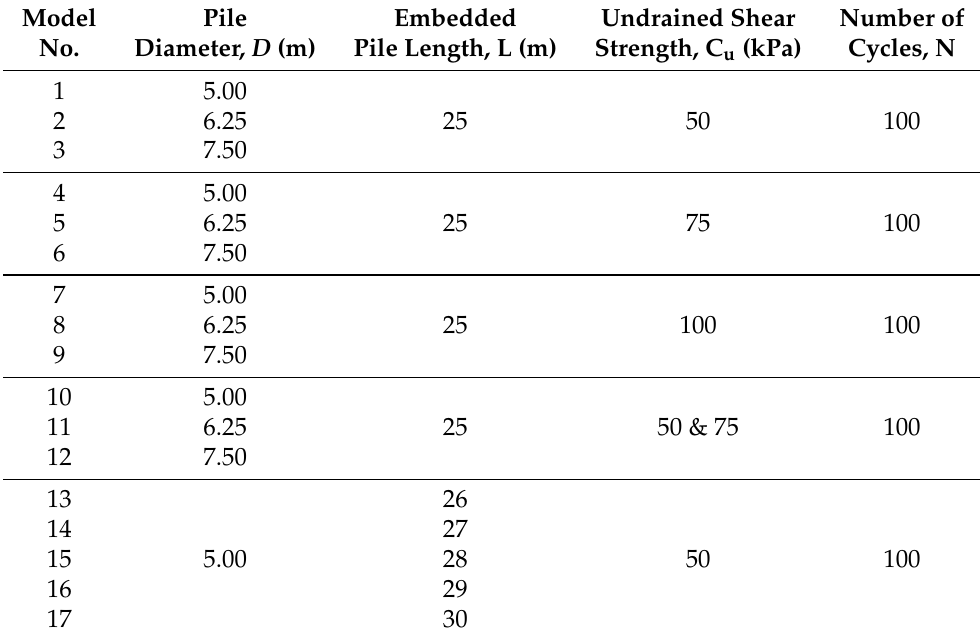
Table 9. Information on the dynamic models conducted study cyclic